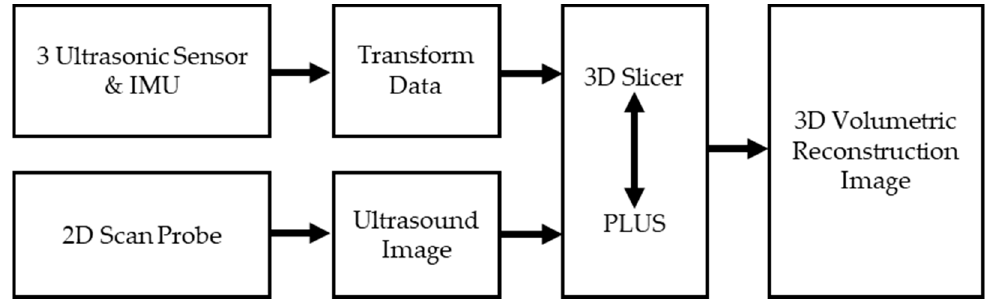
Figure 3. Block diagram for data acquisition and three-dimensional (3D) reconstruction of two-dimensional (2D) ultrasound images by the proposed method. The transformed data from ultrasonic sensors and the IMU, and the 2D ultrasound images from a commercial probe, were combined to reconstruct a 3D volumetric ultrasound image using 3D Slicer and PLUS. One transform data per ultrasound image was tagged that contained position and orientation of the probe.